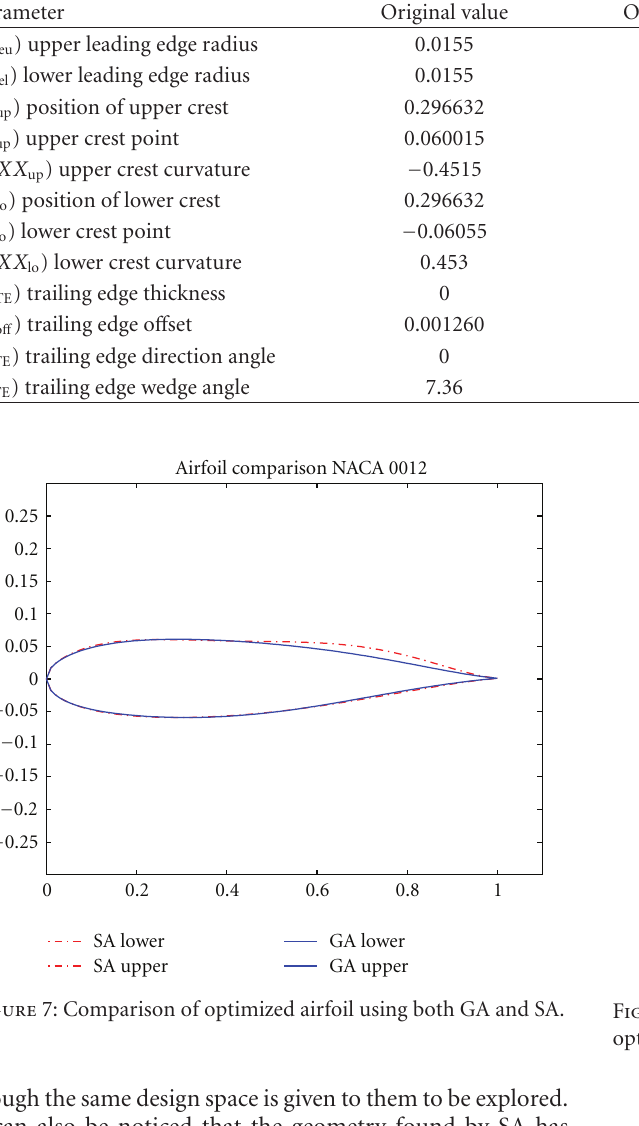
Table 3: Original versus optimized coe ffi cient of